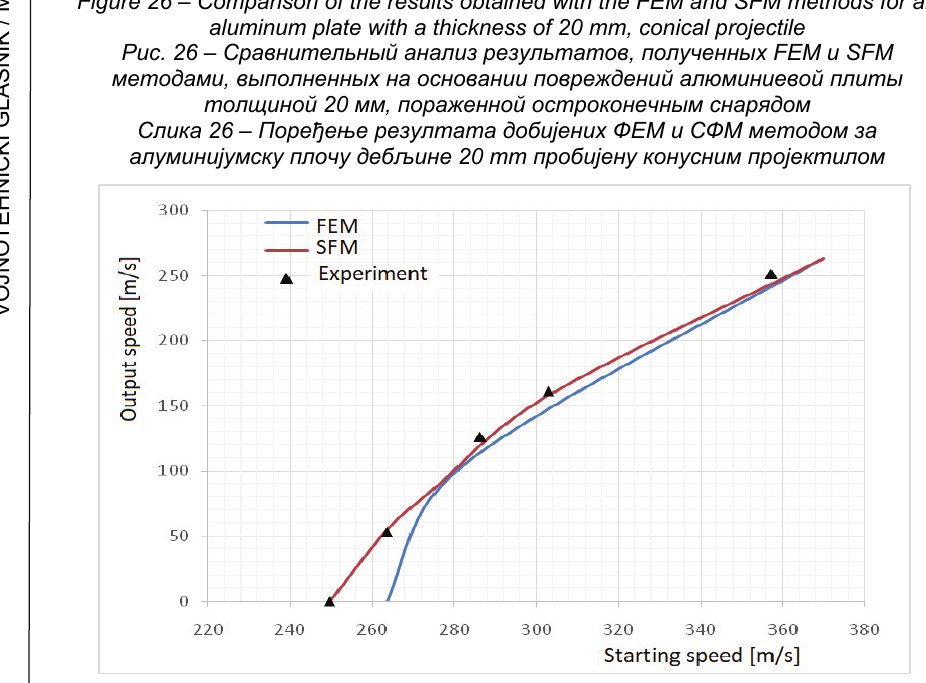
Figure 27 – Comparison of the results obtained with the FEM and SFM methods for an aluminum plate with a thickness of 25 mm, conical projectile Рис . 27 – Сравнительный анализ результатов , полученных FEM и